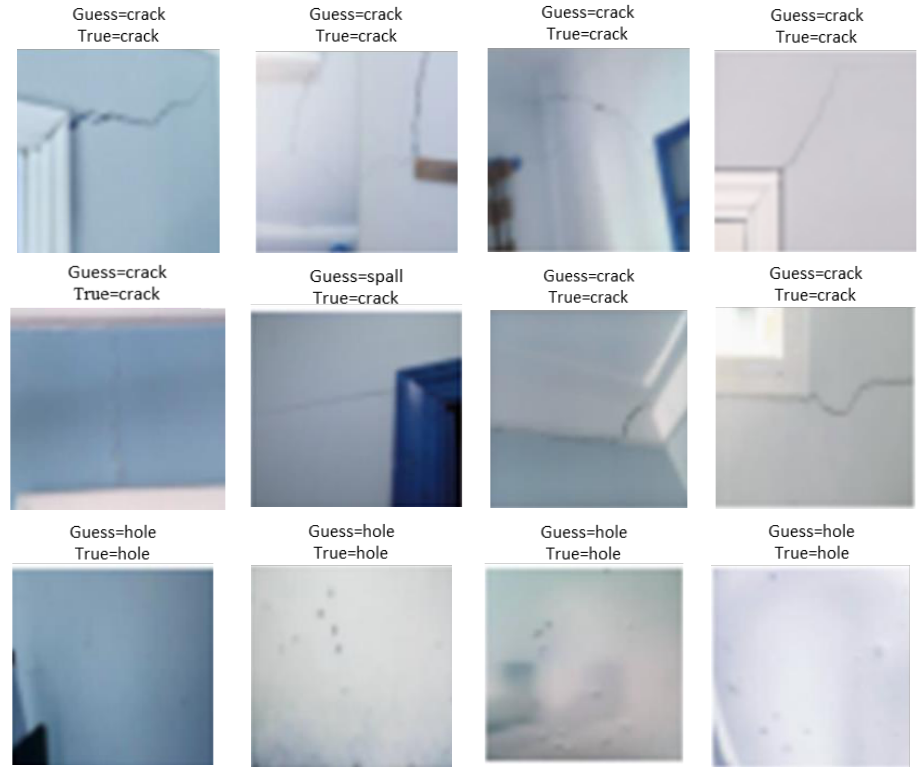
Figure 11. Prediction of wall defects by Conv2D ResNet base